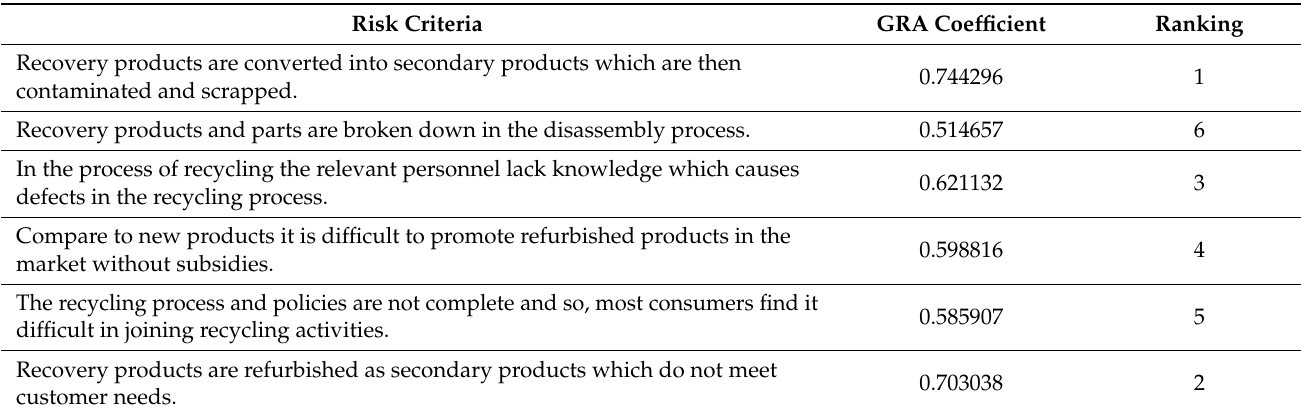
Table 9. The ranking of the green criteria in the green recovery.